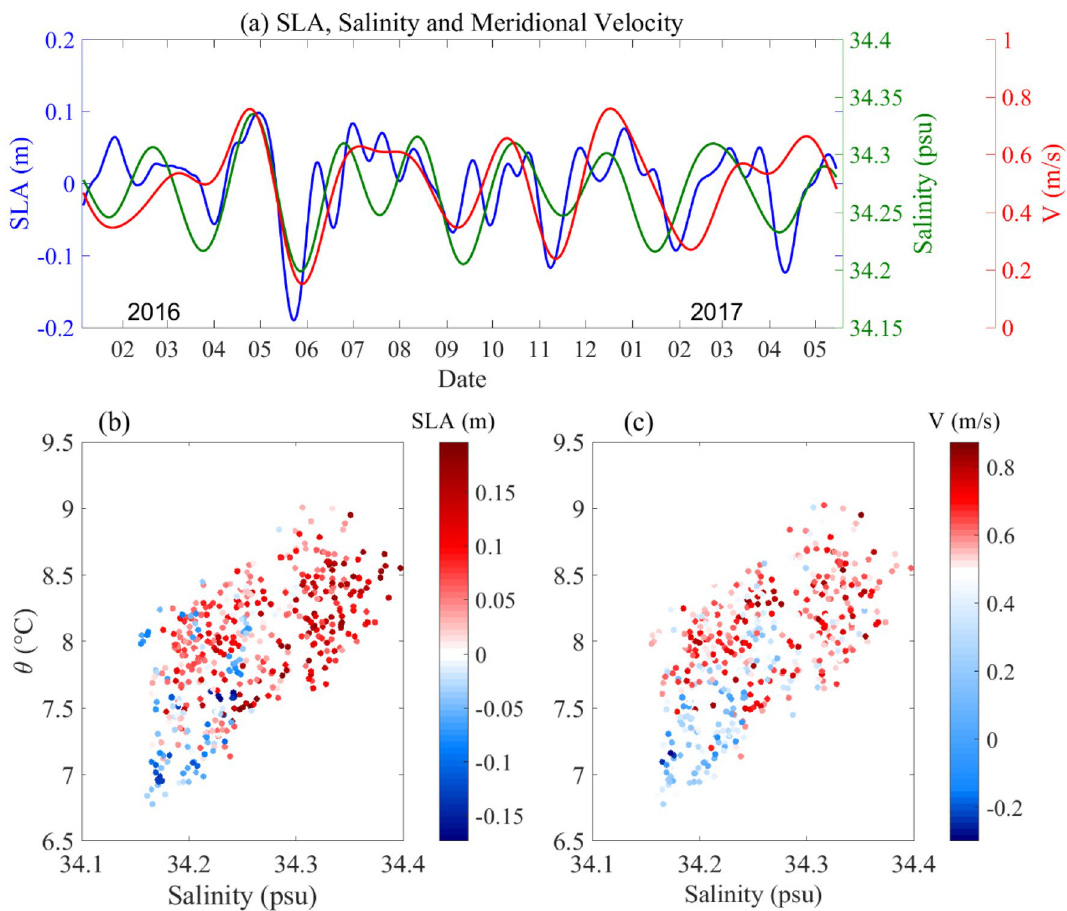
Figure 6. The relationship between the SLA, current and salinity in the intermediate layer. ( a ) Plot of 20–100 day bandpass-filtered time series of SLAs (blue curve), minimum salinity (green curve) and average velocity in the 0–400 m range (red curve). The salinity and velocity data are shown in ( b ) a T-S scatter diagram where the color indicates SLAs and ( c ) a T-S scatter diagram where the color indicates